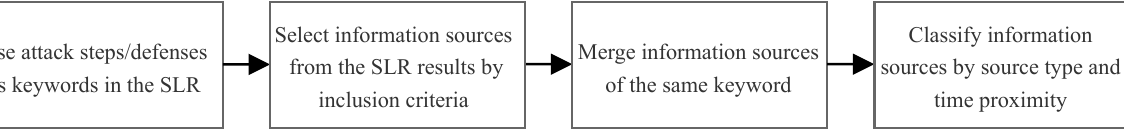
Figure 5. Overview of the information collection